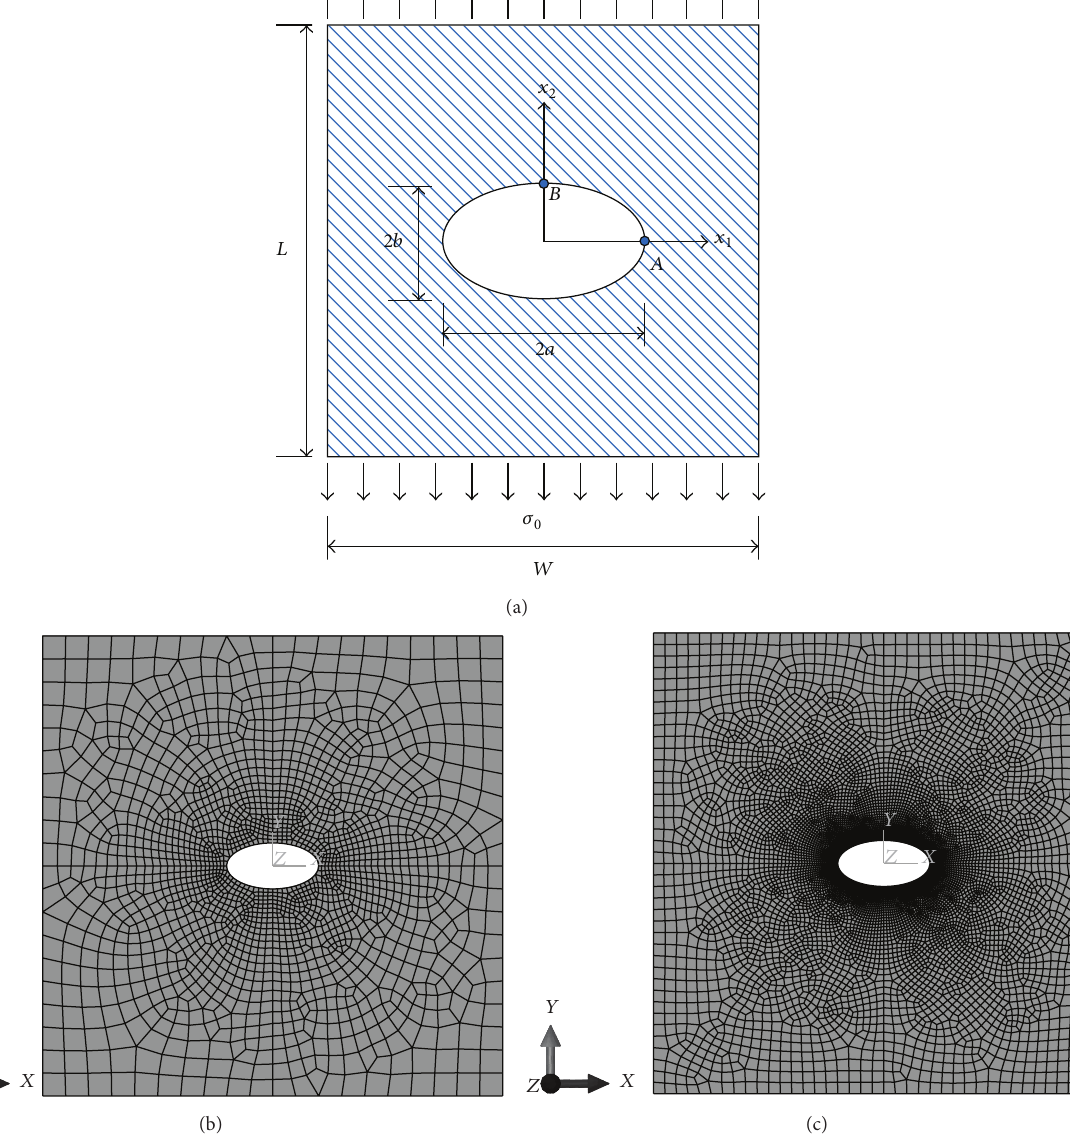
Figure 17: (a) Schematic of an orthotropic composite plate with an elliptic hole under uniform tension, and its mesh configurations for (b) HFS-FEM, 1515 quadratic elements, and (c) ABAQUS, 9498 quadratic